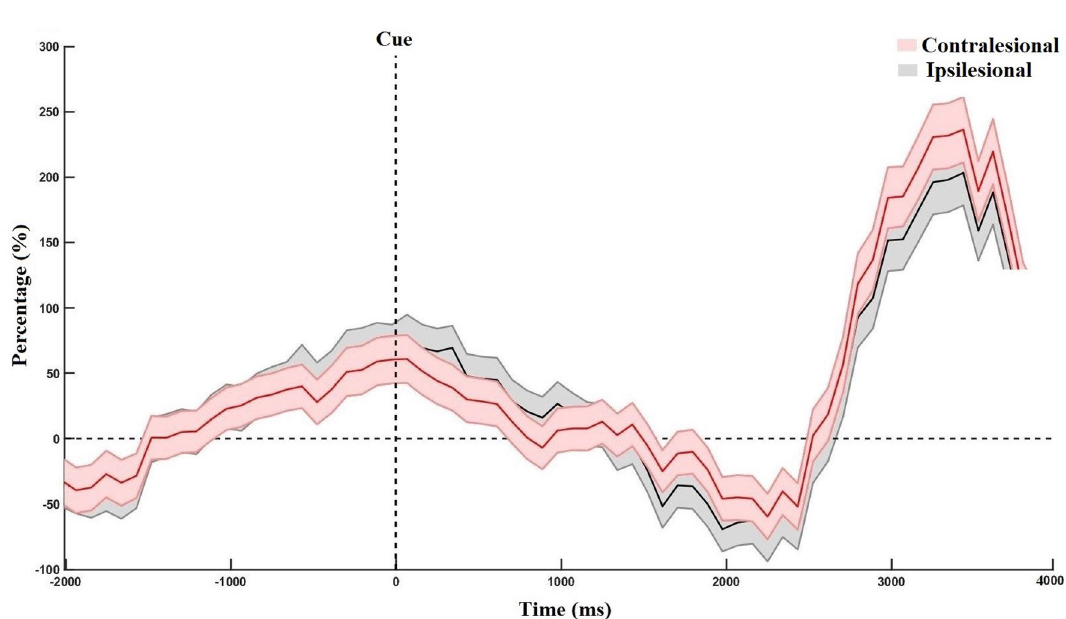
Figure 2. The grand average power change in event-related (de)synchronization (ERD/ERS) in contralesional and ipsilesional hemispheres during motor imagery (i.e. from 0 to 4 s), relative to the resting baseline 1.5 s before the cue.